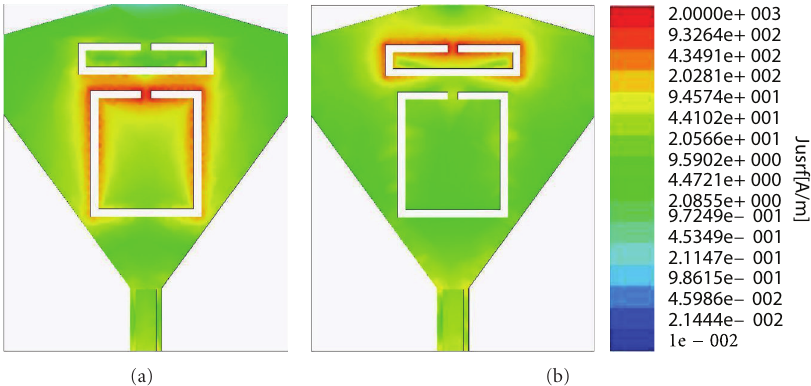
Figure 7: Simulated current distribution of the proposed antenna. (a) 3.5 GHz, (b) 5.5 GHz.